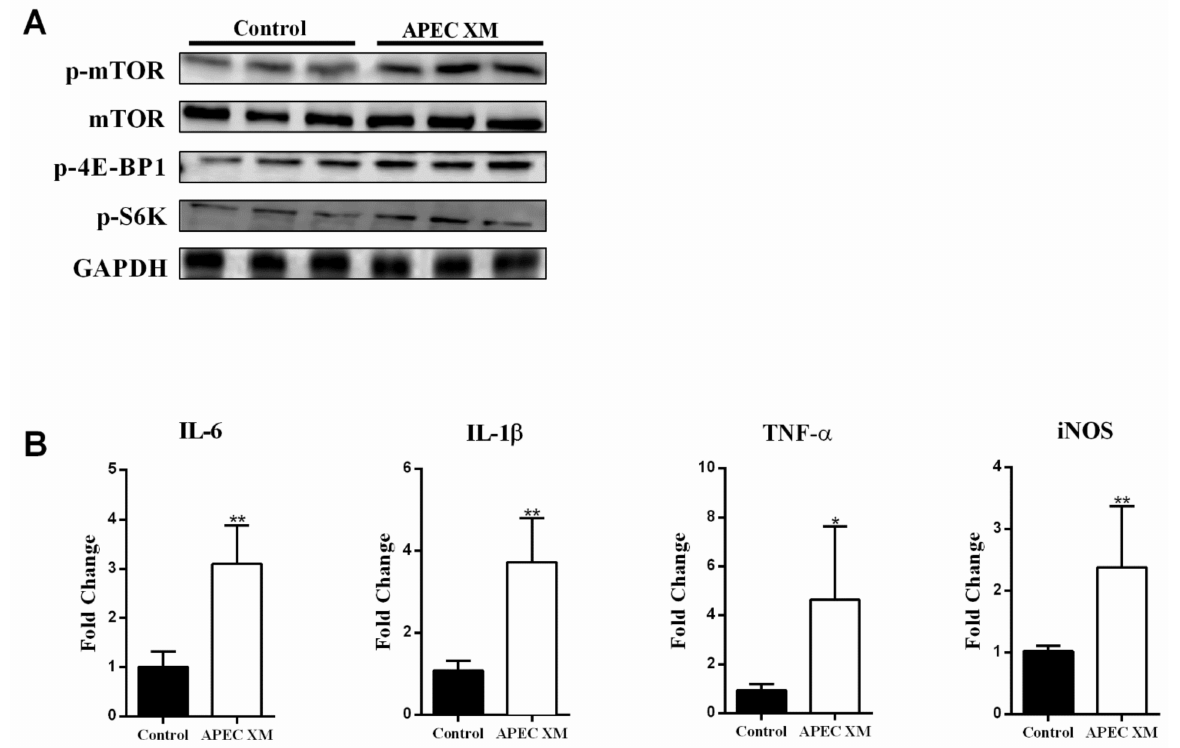
Figure 3. APEC XM activates the mTORC1 pathway and induces inflammation at 1 h post-infection. ( A ) Western blotting showed that up-regulation of phospho-mTOR, mTOR, phospho-4E-BP1 and phosphor-p70 S6 in bEnd.3 cells at 1 h post-infection. The GAPDH was used as the loading control. ( B ) RT-PCR validation the mRNA levels of pro-inflammatory factors after APEC XM infection. Data are from one experiment representative of three independent experiments, with three to six replicates per group. Data represent means ± SD. ns: not significant, * p < 0.05, ** p <